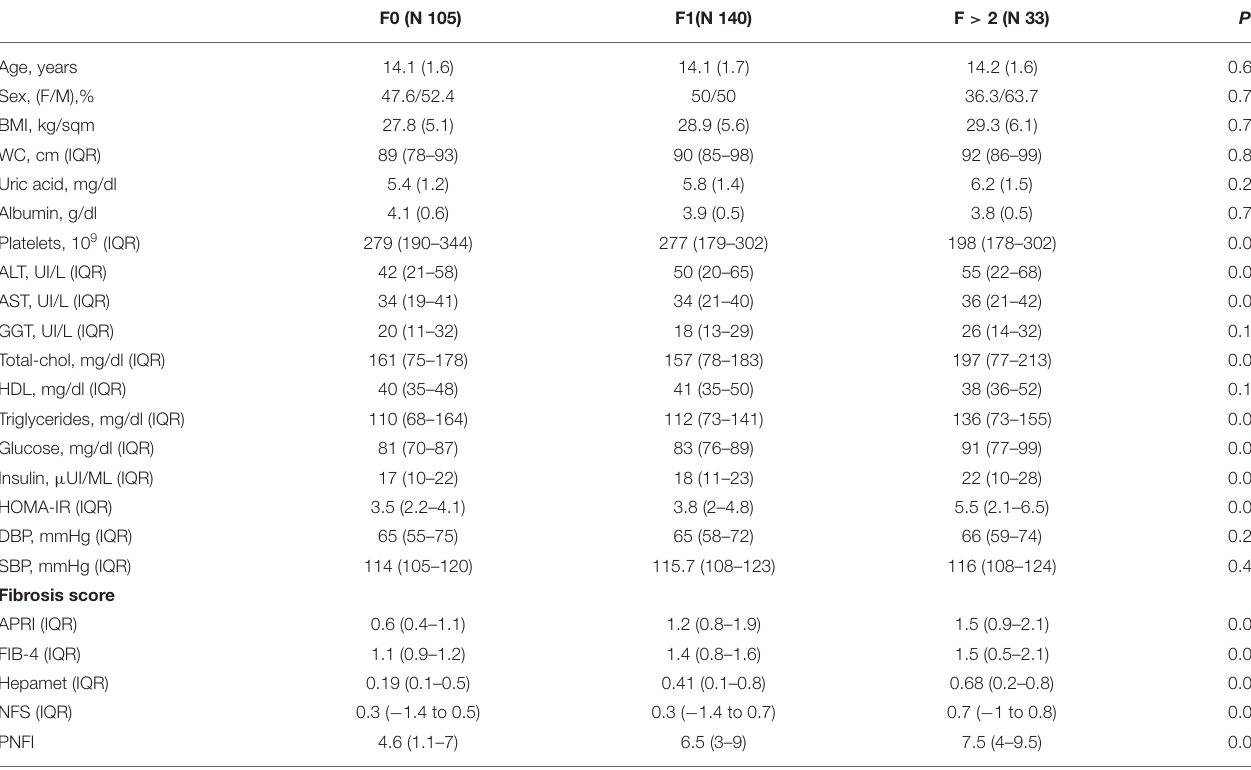
TABLE 3 | Characteristics of the population according to the degree of